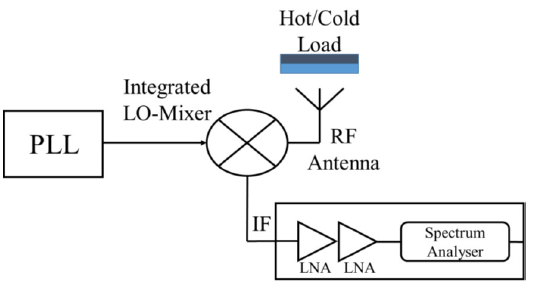
Figure 5. Schematic of the Y-Factor setup used for mixer